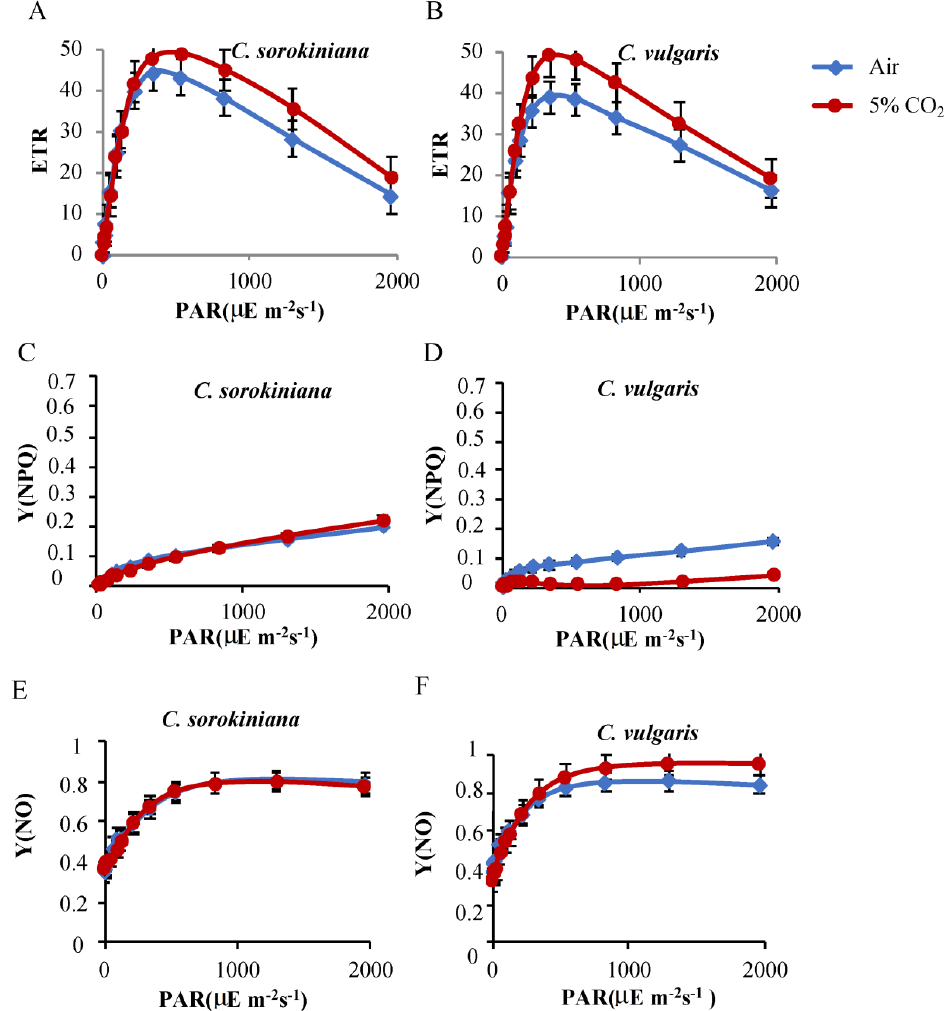
Figure 1. Photosynthetic activity of Cholella strains. ( A , B ) ETR curve evaluated under increasing actinic light (0–2000 µ E m − 2 s − 1 ) of Chlorella sorokinina and Chlorella vulgaris tested under increasing CO 2 (air–5% CO 2 ). Data are the mean ± SE of three biological replicates performed in dupli- cate. ( C , D ) Light responses of Y(NPQ) in the two Chlorella strains under increasing CO 2 (air 5%). ( E , F ) Y(NPQ) corresponds to the fraction of energy dissipated in the form of heat via the regulated non–photochemical quenching mechanism. The mean ± SE was calculated from three independent biological replicates performed in